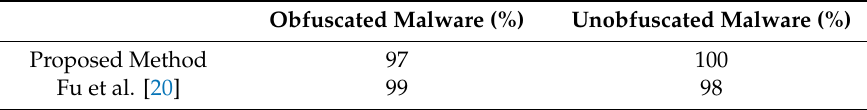
Table 5. Comparison between proposed method and of Fu et al.’s